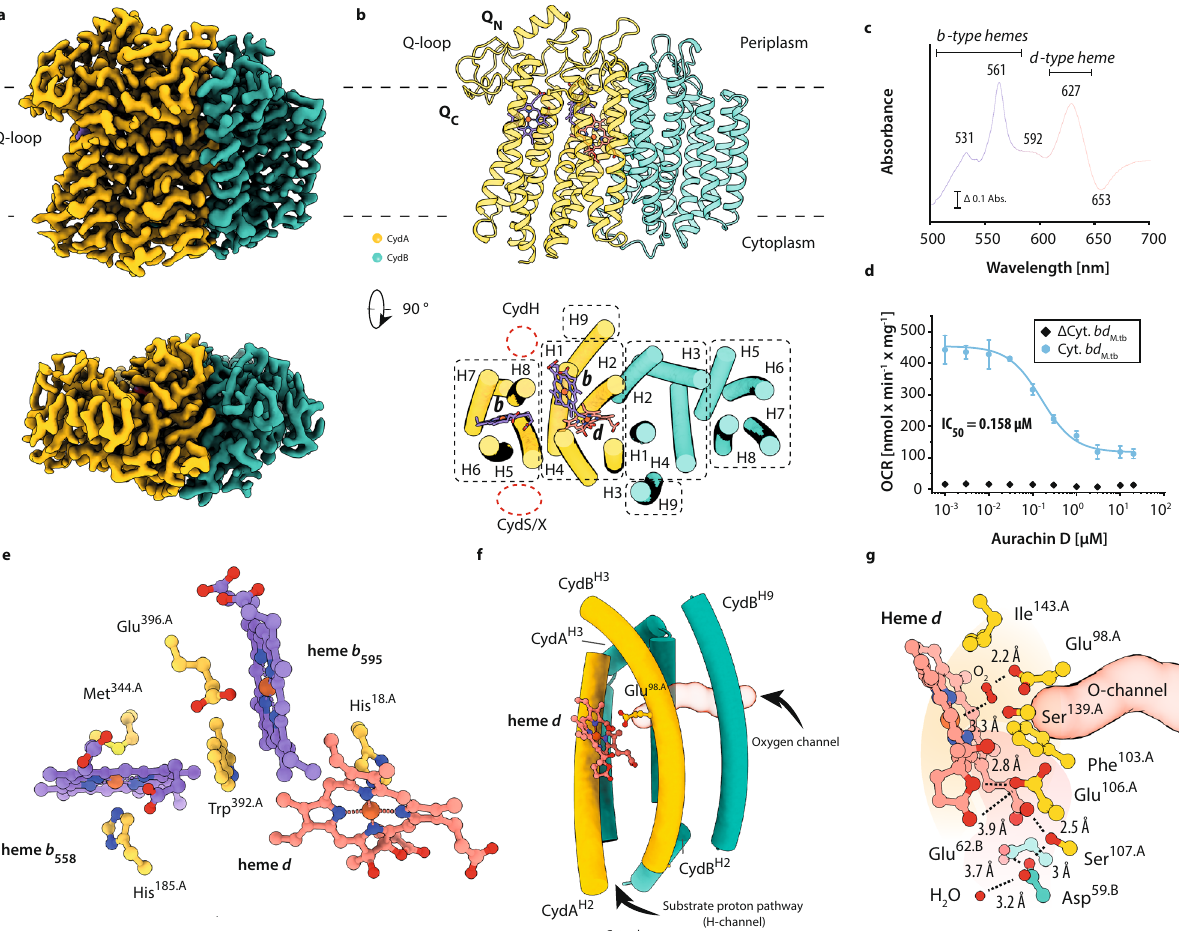
Fig. 1 Cryo-EM structure of the bd oxidase from M. tuberculosis . a Surface representation of the bd oxidase cryo-EM density map at 2.5 Å resolution. The bd oxidase consists of a heterodimeric CydAB core dimer The Q-loop of CydA comprises a mostly disordered Q N and an ordered Q C segment that are both exposed to the periplasm. b Cyt. bd Mtb contains 18 membrane-spanning helices. CydA and CydB form a pseudo-symmetric dimer. All heme cofactors ( b 558 , b d ) are located within CydA. Dashed red circles indicate the positions of accessory transmembrane helices in other bd oxidase structures. 595 , and heme c Redox-minus-oxidized difference UV – vis spectrum of puri fi ed cyt. bd Mtb . d Oxygen consumption rates from biological replicates ( n = 7) of IMVs containing overproduced cytochrome bd oxidase. Control experiments were performed with IMVs from Δ cydAB cells containing an empty expression vector. Control data were obtained from biological triplicates ( n = 3). All data are presented as mean values ± SD. e Triangular arrangement of the heme cofactors in CydA. f The oxygen conducting channel emerging from the membrane plane and running towards the active site. g Heme d sits in an amphipathic pocket where the hydrophilic proton channel and hydrophobic oxygen pathway converge at the dioxygen binding site. Distances between water molecules and conserved hydrophilic residues are shown. Color scheme: CydA, yellow; CydB, green; b -type hemes, purple; heme d ,